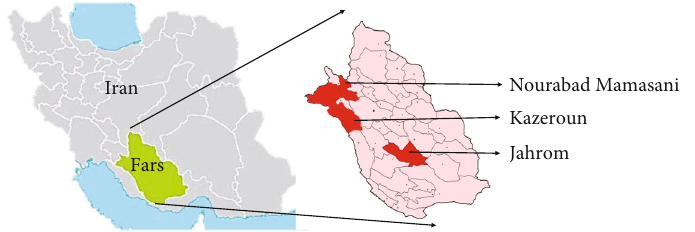
Figure 1: Geographic region image of Fars province (Jahrom, Nourabad Mamasani, and Kazeroun) in the south of